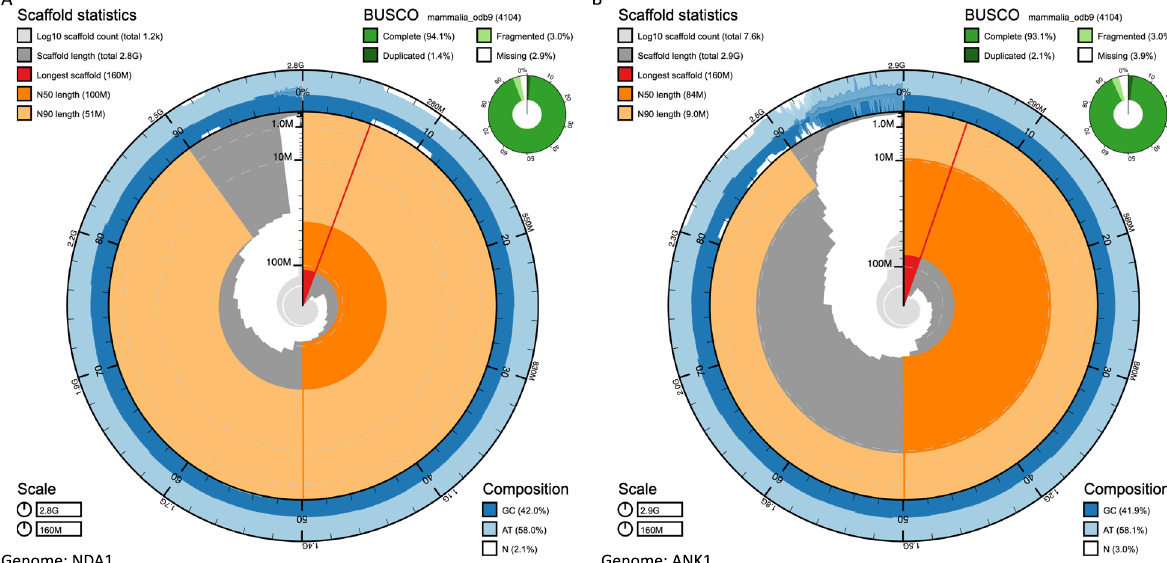
Fig. 2 Snail plots of the N ’ Dama (NDA1) and Ankole (ANK1) genome assemblies. Key metrics are shown for the ( A ) N ’ Dama and ( B ) Ankole genomes such as the longest scaffold (red vertical line), N50 (orange track), N90 (light orange track), GC content (external blue track) and BUSCO scores (outer circular pie chart in green). The region of elevated N content in the N ’ Dama assembly corresponds to a 5 Mb gap in one of the contigs matching a region of generalised low identity in all of the fi ve assemblies (Supplementary Fig. 4). Even though this region contained an un fi lled gap we observe that the regions fl anking the gap align to directly contiguous portions of the genome in other assemblies, and therefore that the gap in this region is potentially smaller than represented